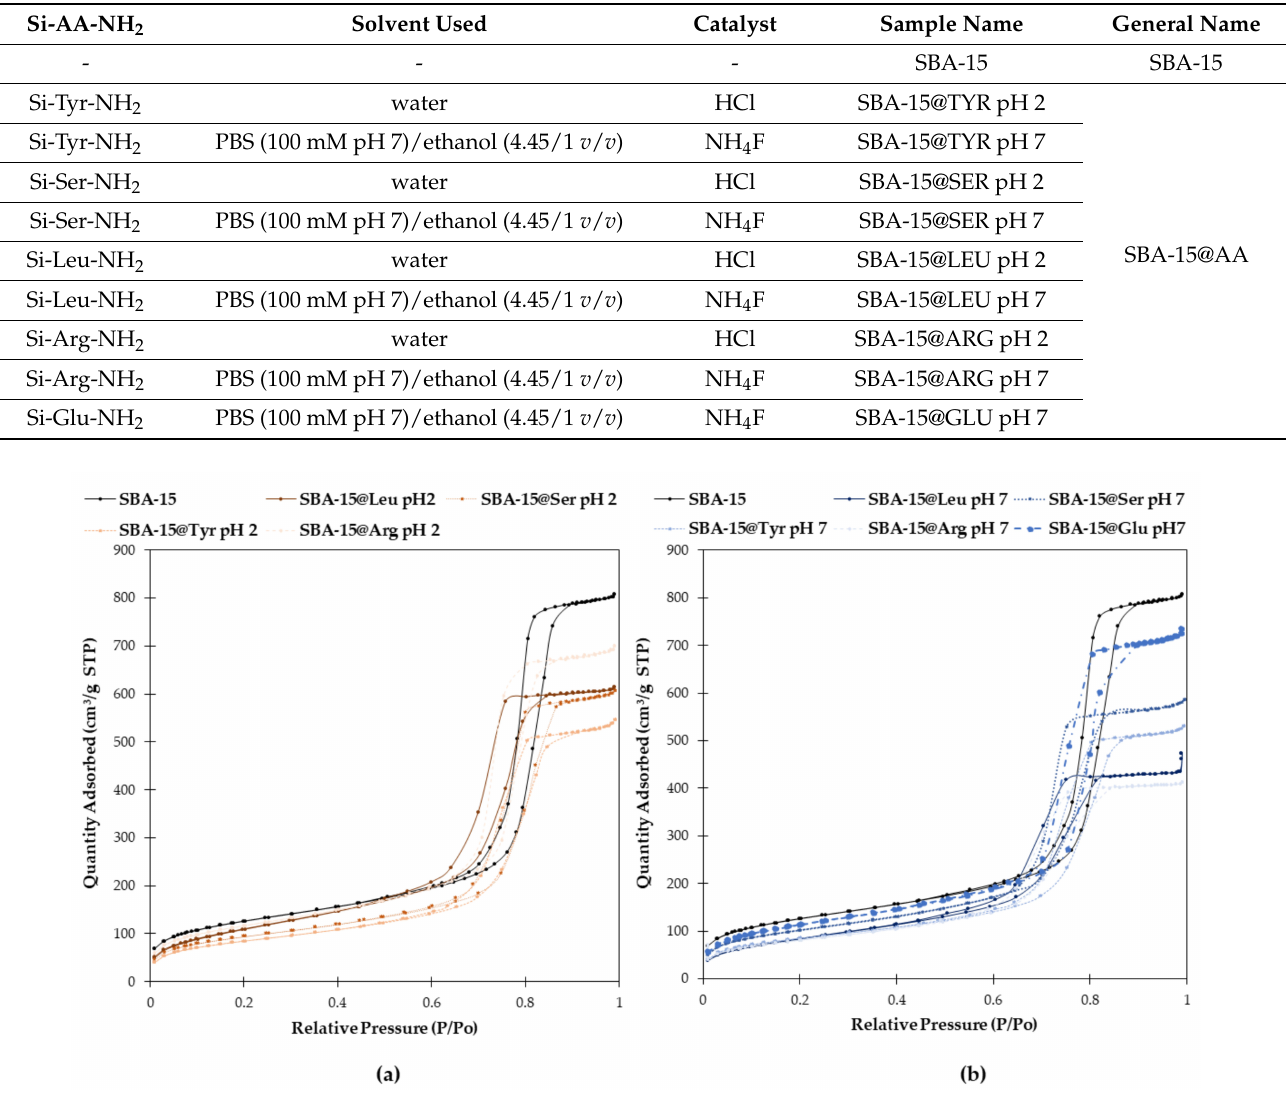
Figure 6. Nitrogen isotherms at 77K of bare SBA-15 (black) and functionalized SBA-15@AA at pH 2 ( a ) and pH 7 ( b